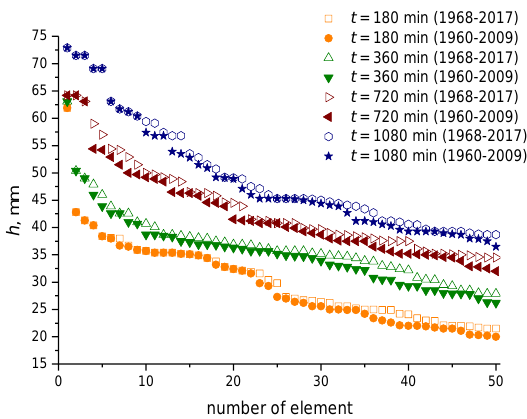
Fig. 3. Comparison of 180, 360, 720 and 1080 minutes duration rainfall in the periods 1960–2009 and 1968–2017.